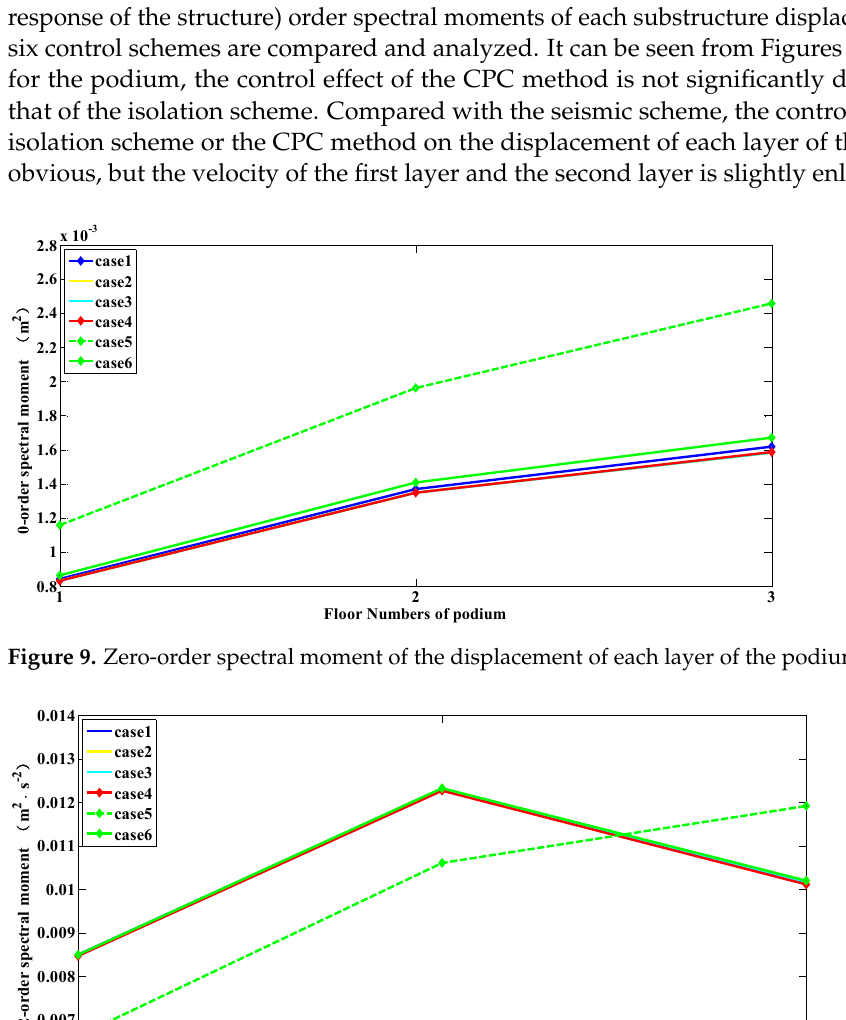
Figure 8. Time-varying variance of top-level absolute acceleration .